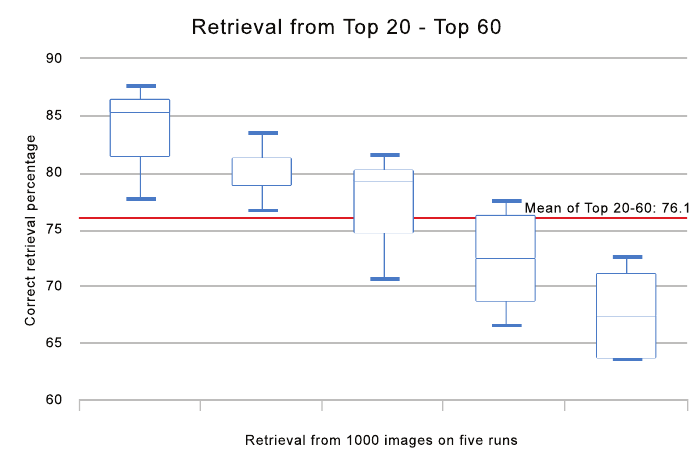
Figure 4. Image retrieval performance from top 20 to 60 images.